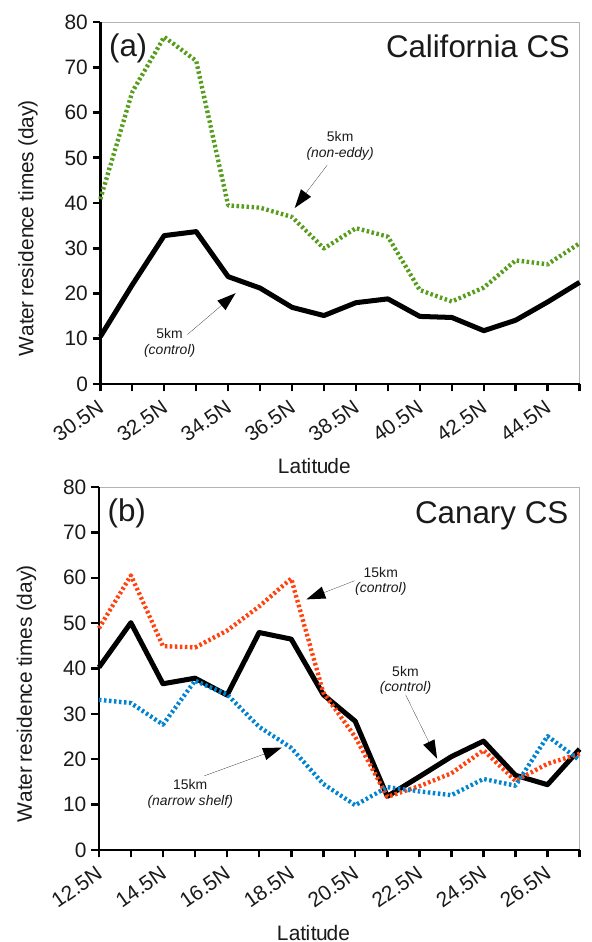
Fig. 10. (a) Meridional distribution of the water residence times in the 100km wide nearshore area in the California CS as simulated in the control simulation (solid black) and the non-eddy simulation (dashed green). (b) Meridional distribution of the water residence times in the 100km wide nearshore area in the Canary CS as sim- ulated in the control 5km simulation (solid black), the 15km sim- ulation with unaltered topography (dashed orange) and the 15km narrowed-shelf simulation (dashed